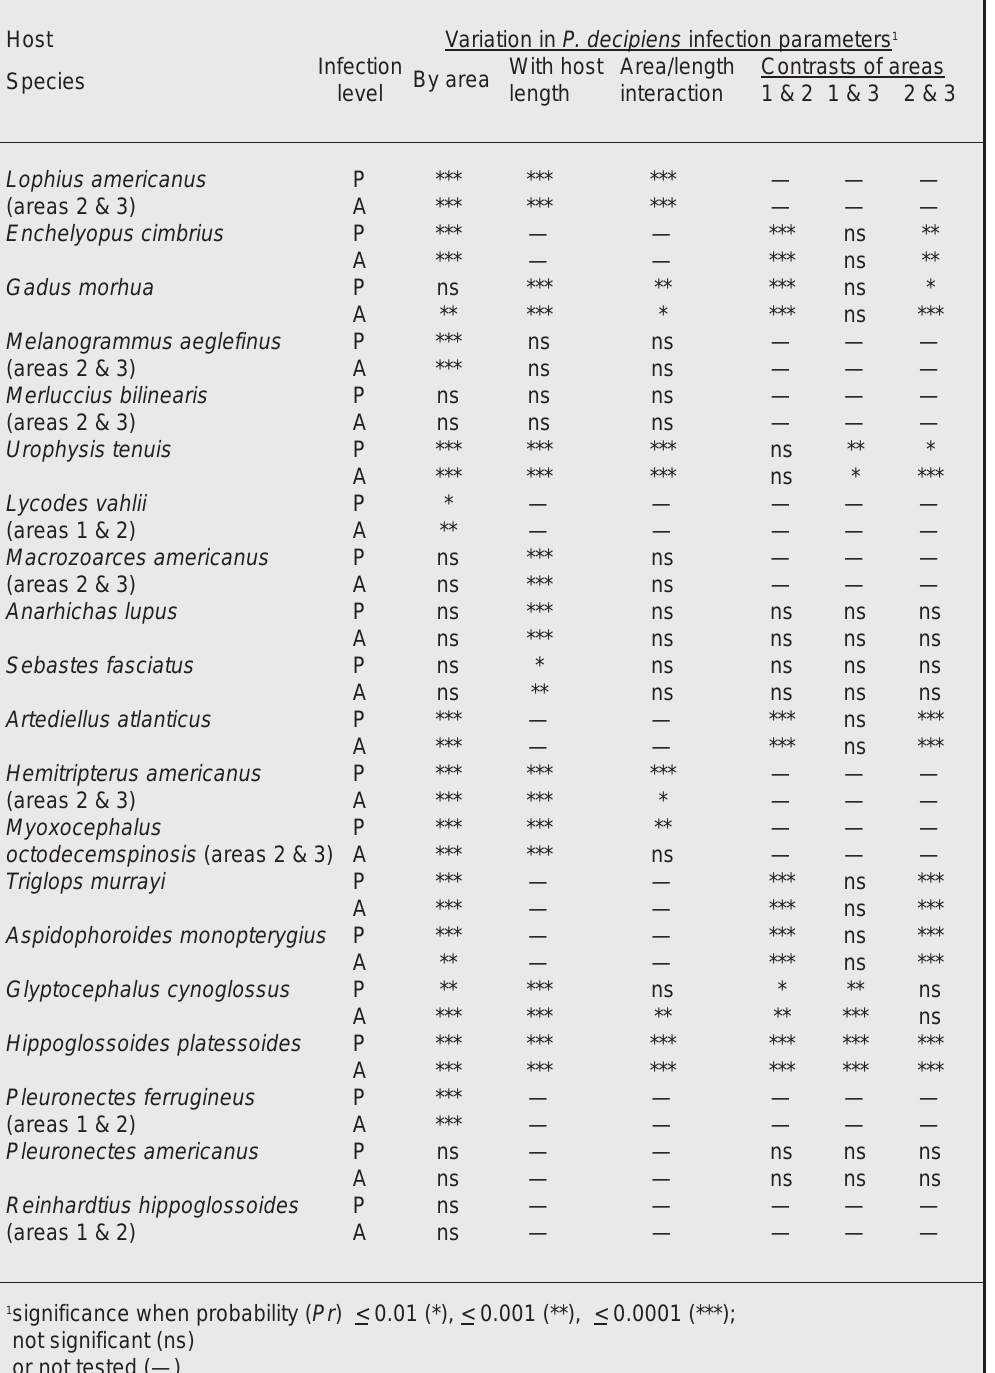
Table 2 . Larval sealworm ( Pseudoterranova decipiens ) infections in various groundfish species from the Breton Shelf (1), Sable Island Bank (2) and the northeastern Gulf of Maine (3); results of 2-way-ANOVAs of sealworm prevalence (P) and abundance (A) with host length and geographic origin.